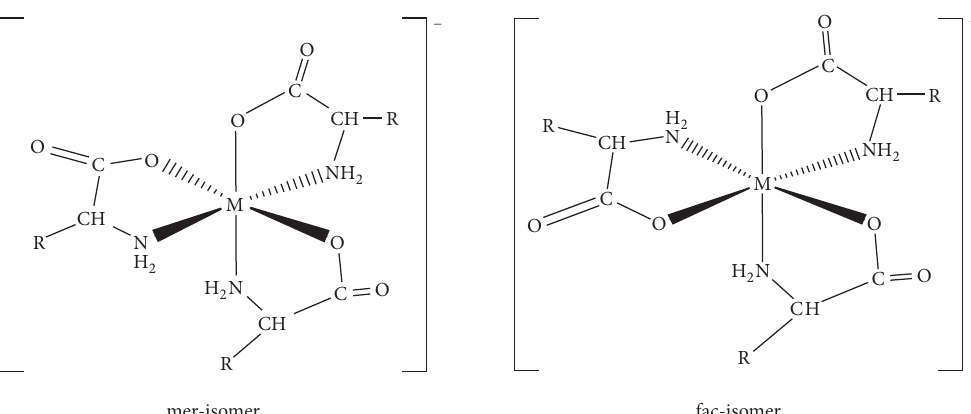
Figure 5: The proposed structure for the geometric isomers for the tris-chelate complexes. R = –H; glycinato complexes; –CH 2 COOH; aspartato